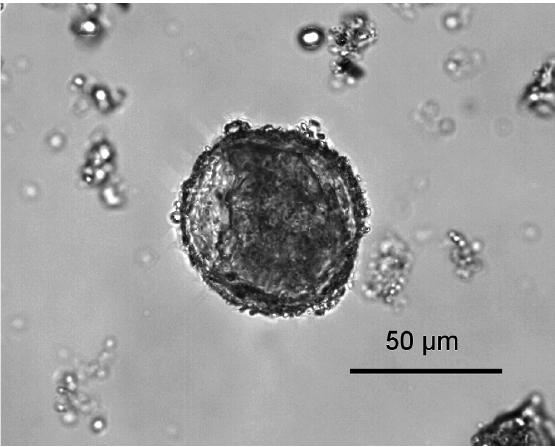
Figure 1 - Ascaridae egg found in cynodont coprolite dated 240 million years